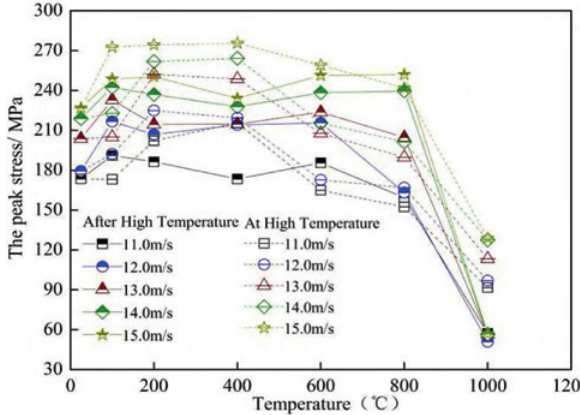
Fig. 9: The elastic modulus variation of sandstone after as well as under high